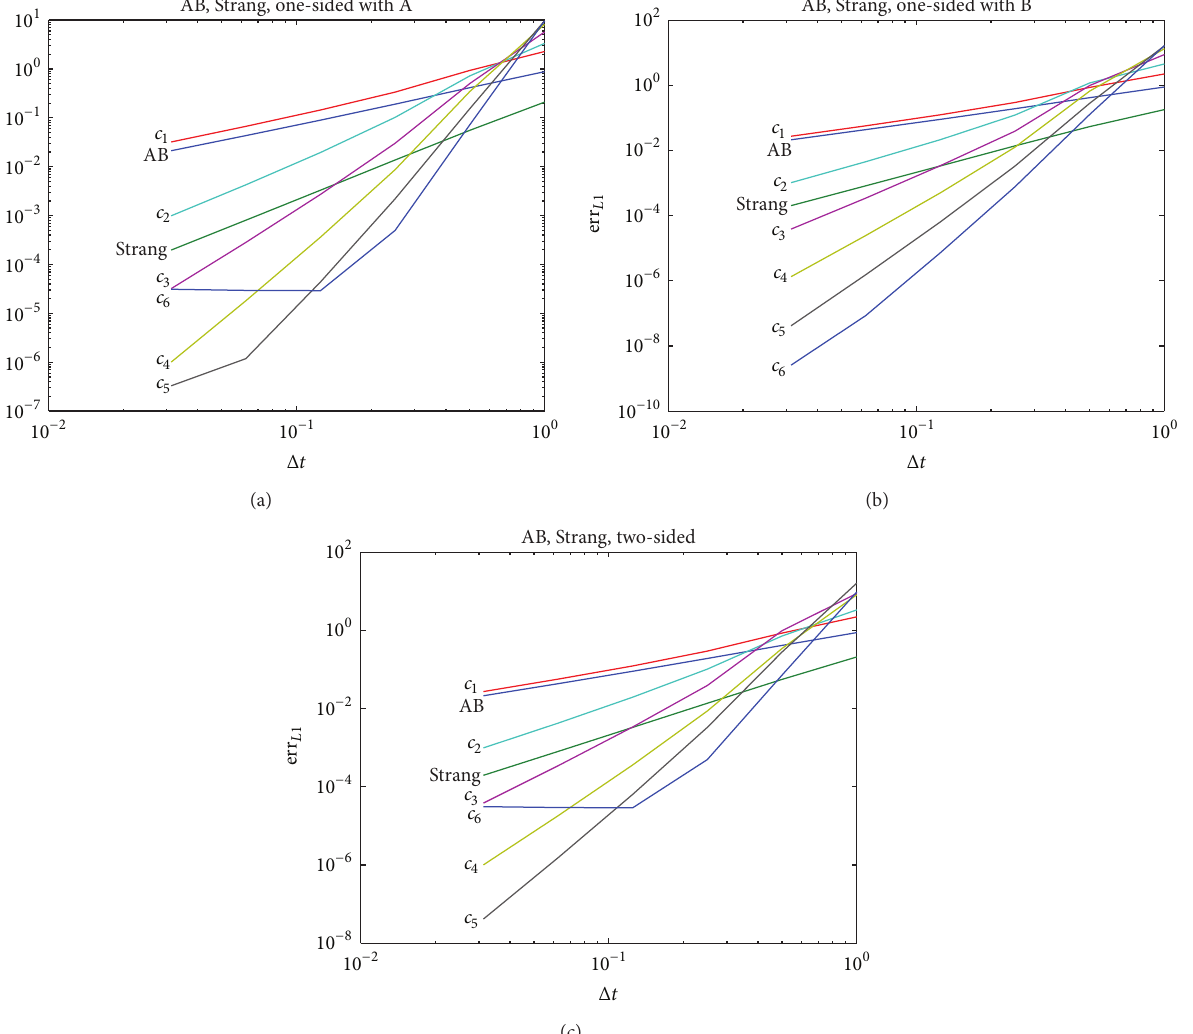
Figure 1: Numerical errors of the one-sided splitting scheme with 𝐴 (a), the one-sided splitting scheme with 𝐵 (b), and the iterative schemes with 1,...,6 iterative steps